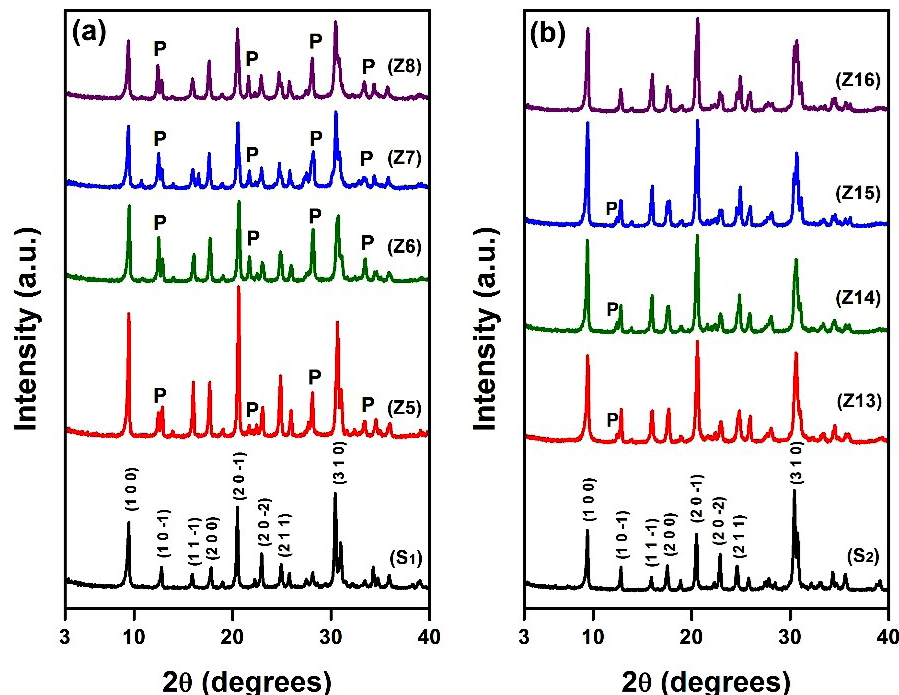
seeds and (b) S seeds. P = Zeolite P 1 2